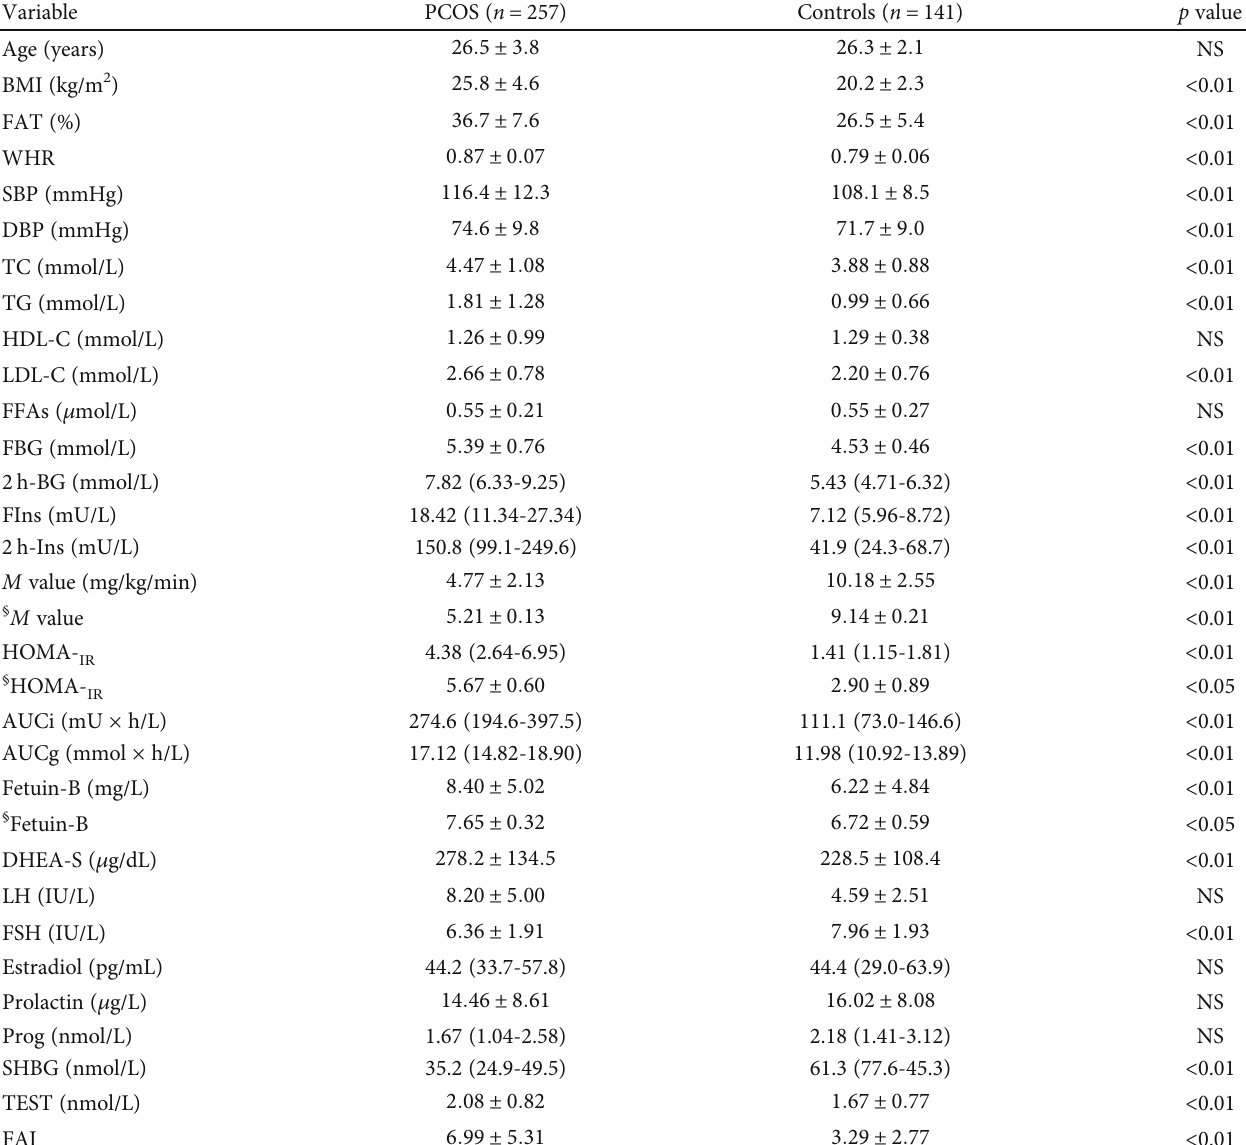
Table 1: Main clinical features and serum Fetuin-B concentrations in PCOS and healthy